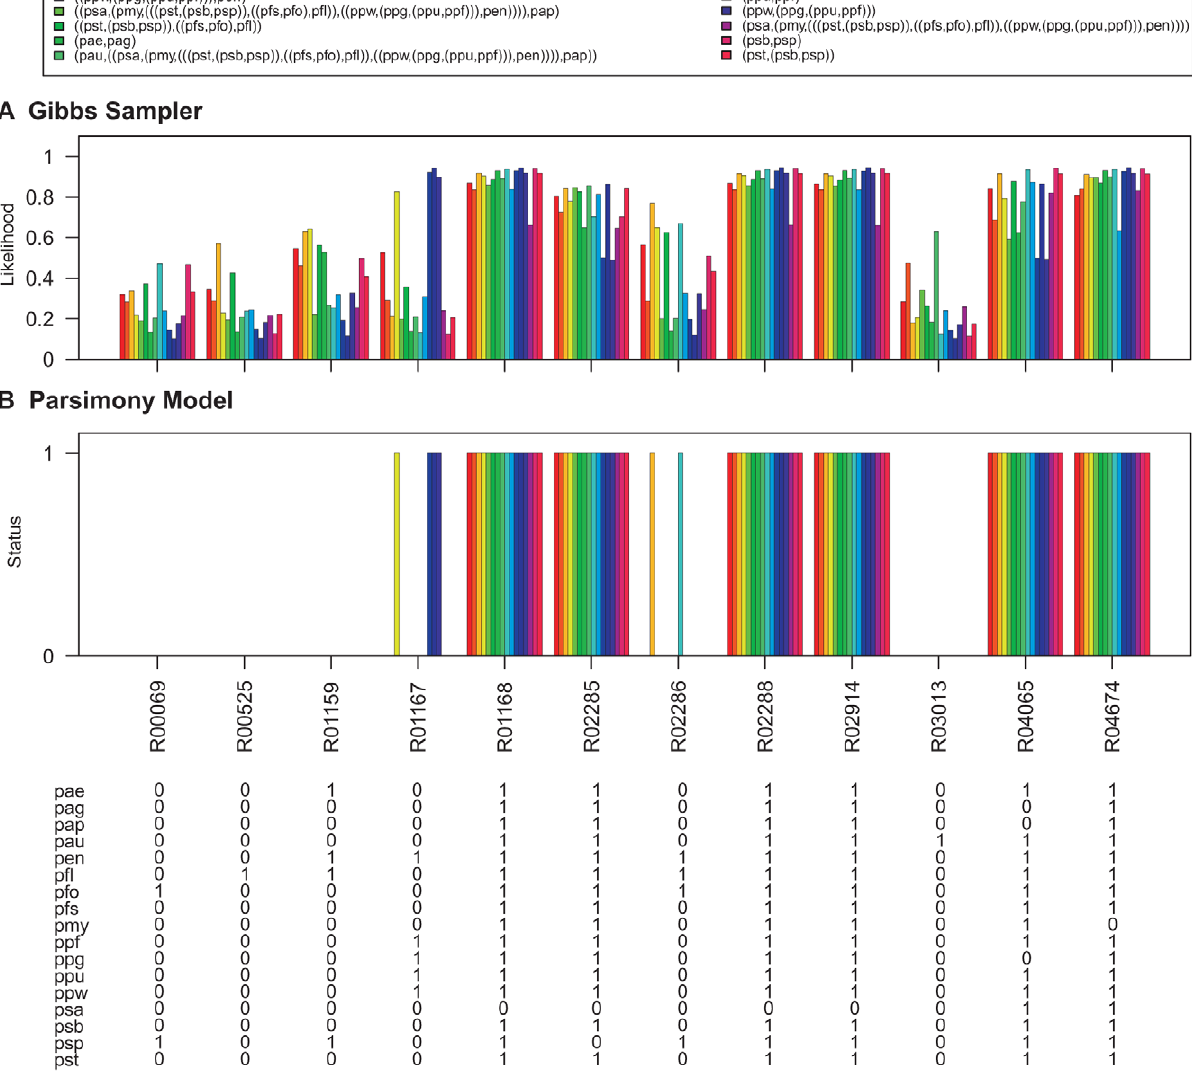
Figure 10. Ancestral network reconstruction for the histidine metabolism map. The ancestral networks were reconstructed over the Pseudomonas phylogeny shown in Figure 6A. Also shown in the bottom panel is the distribution of reactions across different Pseudomonas strains. (A) Likelihood of being present for alterable reactions at various levels of Pseudomonas phylogeny obtained by calculating the proportion of times each hyperedge was present in the networks sampled by the Gibbs sampler. (B) Reaction status obtained under maximum parsimony calculated using the Fitch algorithm [26]. When assigning the reactions at the ancestral nodes the ties were resolved in favor of presence of reactions. Strain abbreviations: pae: P. aeruginosa PAO1, pap: P. aeruginosa PA7, pau: P. aeruginosa PA14, pag: P. aeruginosa LESB58, pen: P. entomophila L48, pfl: P. fluorescens Pf-5, pfo: P. fluorescens Pf0-1, pfs: P. fluorescens SBW25, pmy: P. mendocina ymp, ppf: P. putida F1, ppg: P. putida GB-1 ppu: P. putida KT2440, ppw: P. putida W619, psa: P. stutzeri A1501, psb: P. syringae pv. syringae B728a, psp: P. syringae pv. phaseolicola 1448A, and pst: P. syringae pv. tomato